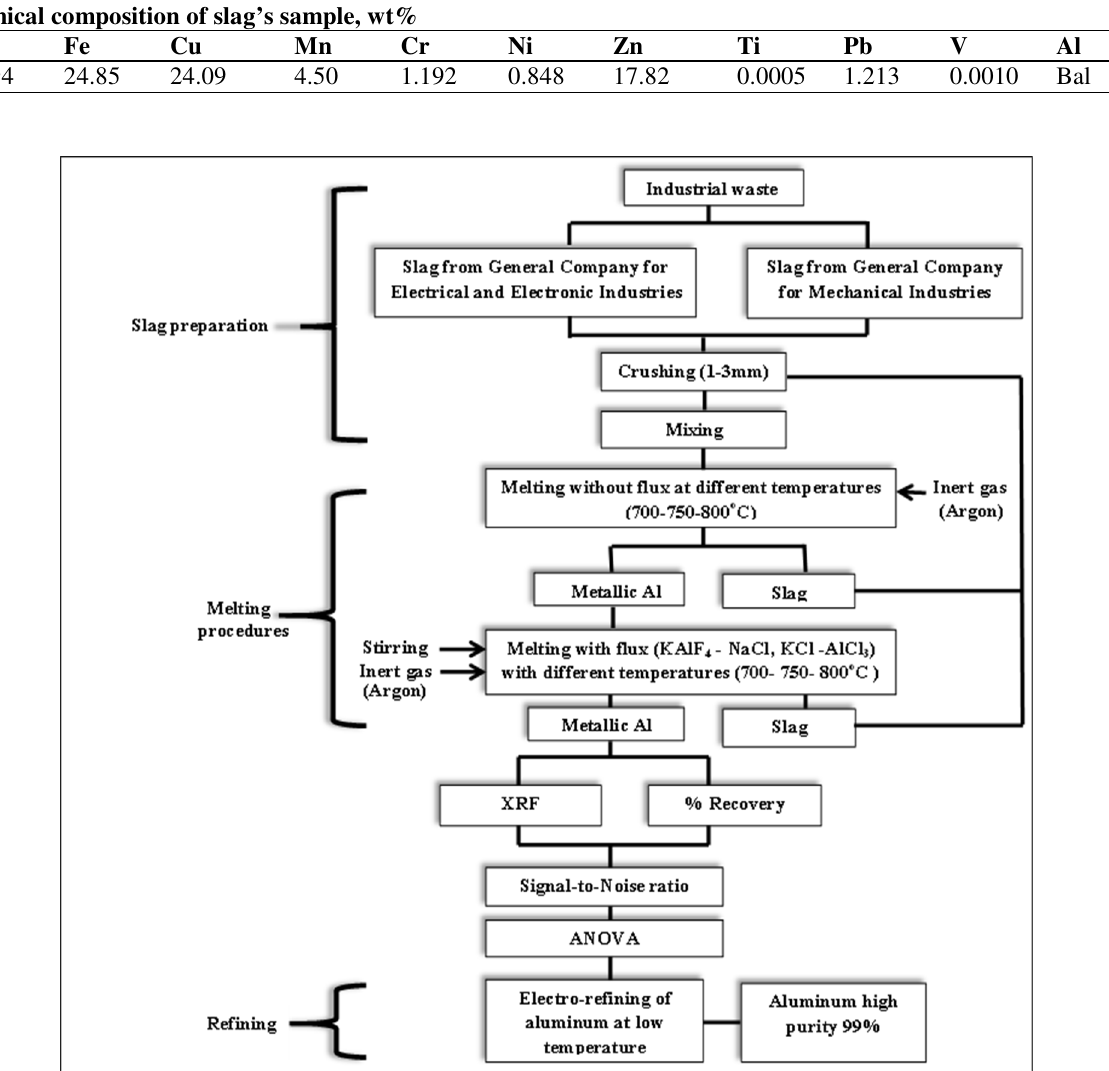
Fig. 1. Flow diagram of beneficiation